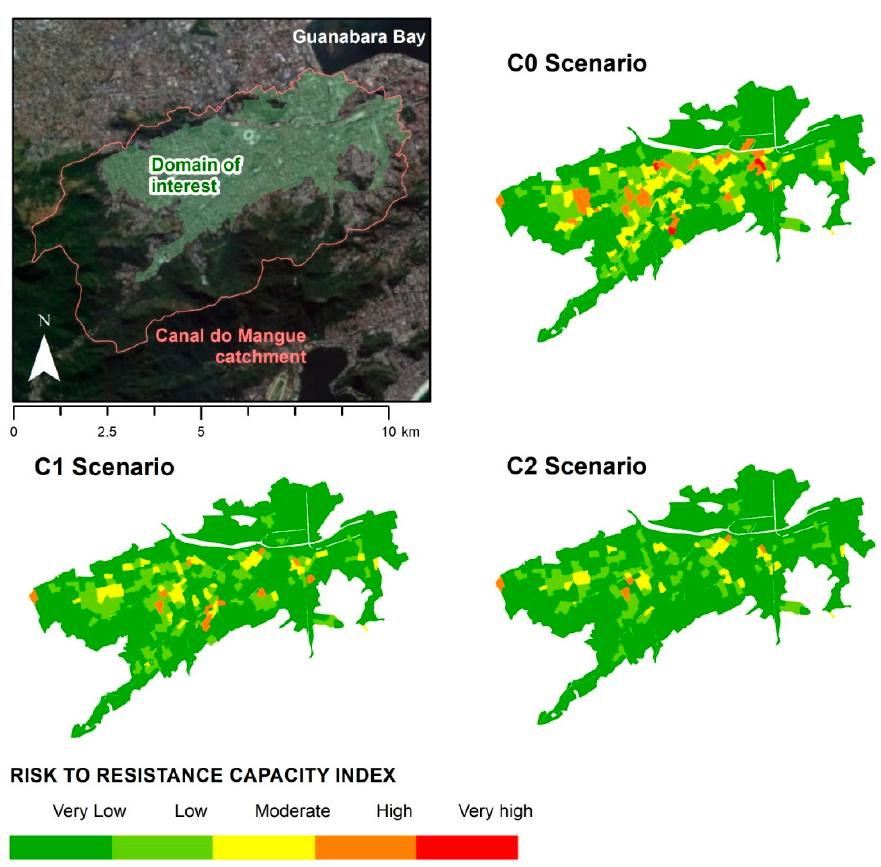
Figure 12. Risk to Resistance Capacity Index (RCI) considering a sequence of events over a 50-year horizon: (C0) without interventions, (C1) concentrated measures and (C2) distributed interventions.